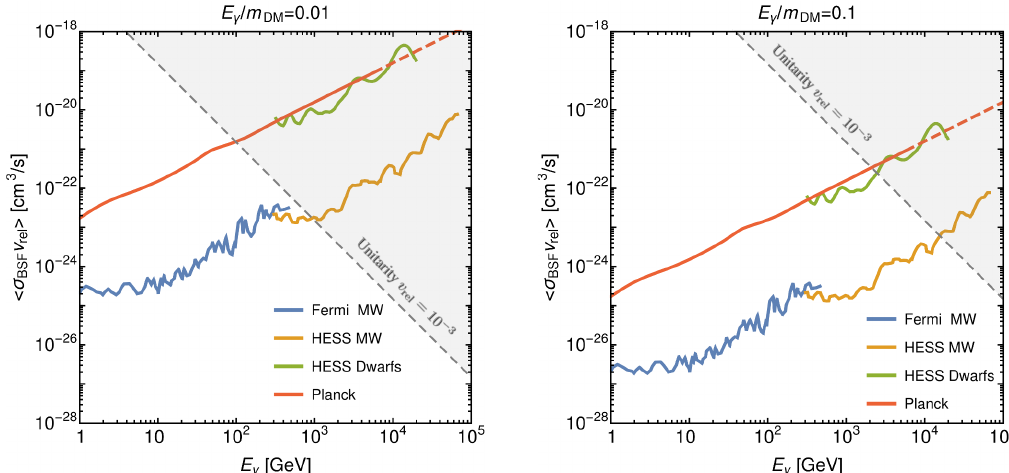
Figure 8: Recasting of indirect detection limits from Planck [ 80 ] , H.E.S.S. [ 81, 82 ] and Fermi [ 83 ] on DM annihilation into two photons, for bound state formation via photon emission, for two examples of E γ / m unitarity constraint for DM annihilation, 〈 σ v relative velocity for DM in the Milky Way. The dashed line for the Planck constraint indicates where we have extrapolated the efficiency of energy deposition, f the tables [ 84 ] used by